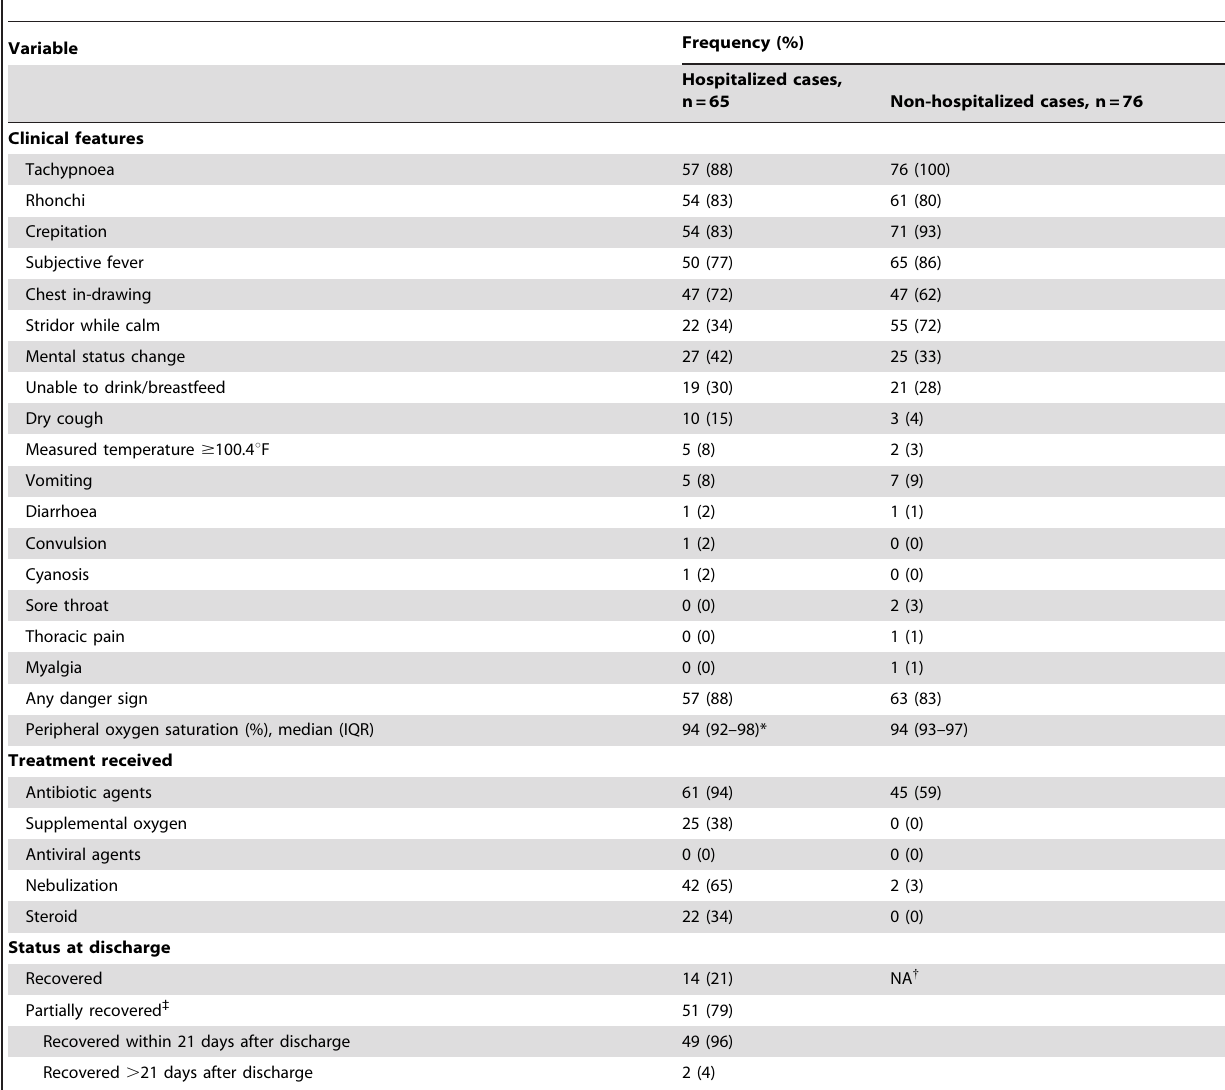
Table 6. Clinical features, treatment and status at discharge of the hospitalized children aged , 5 years with severe acute respiratory infections in Matlab, Bangladesh, June–October